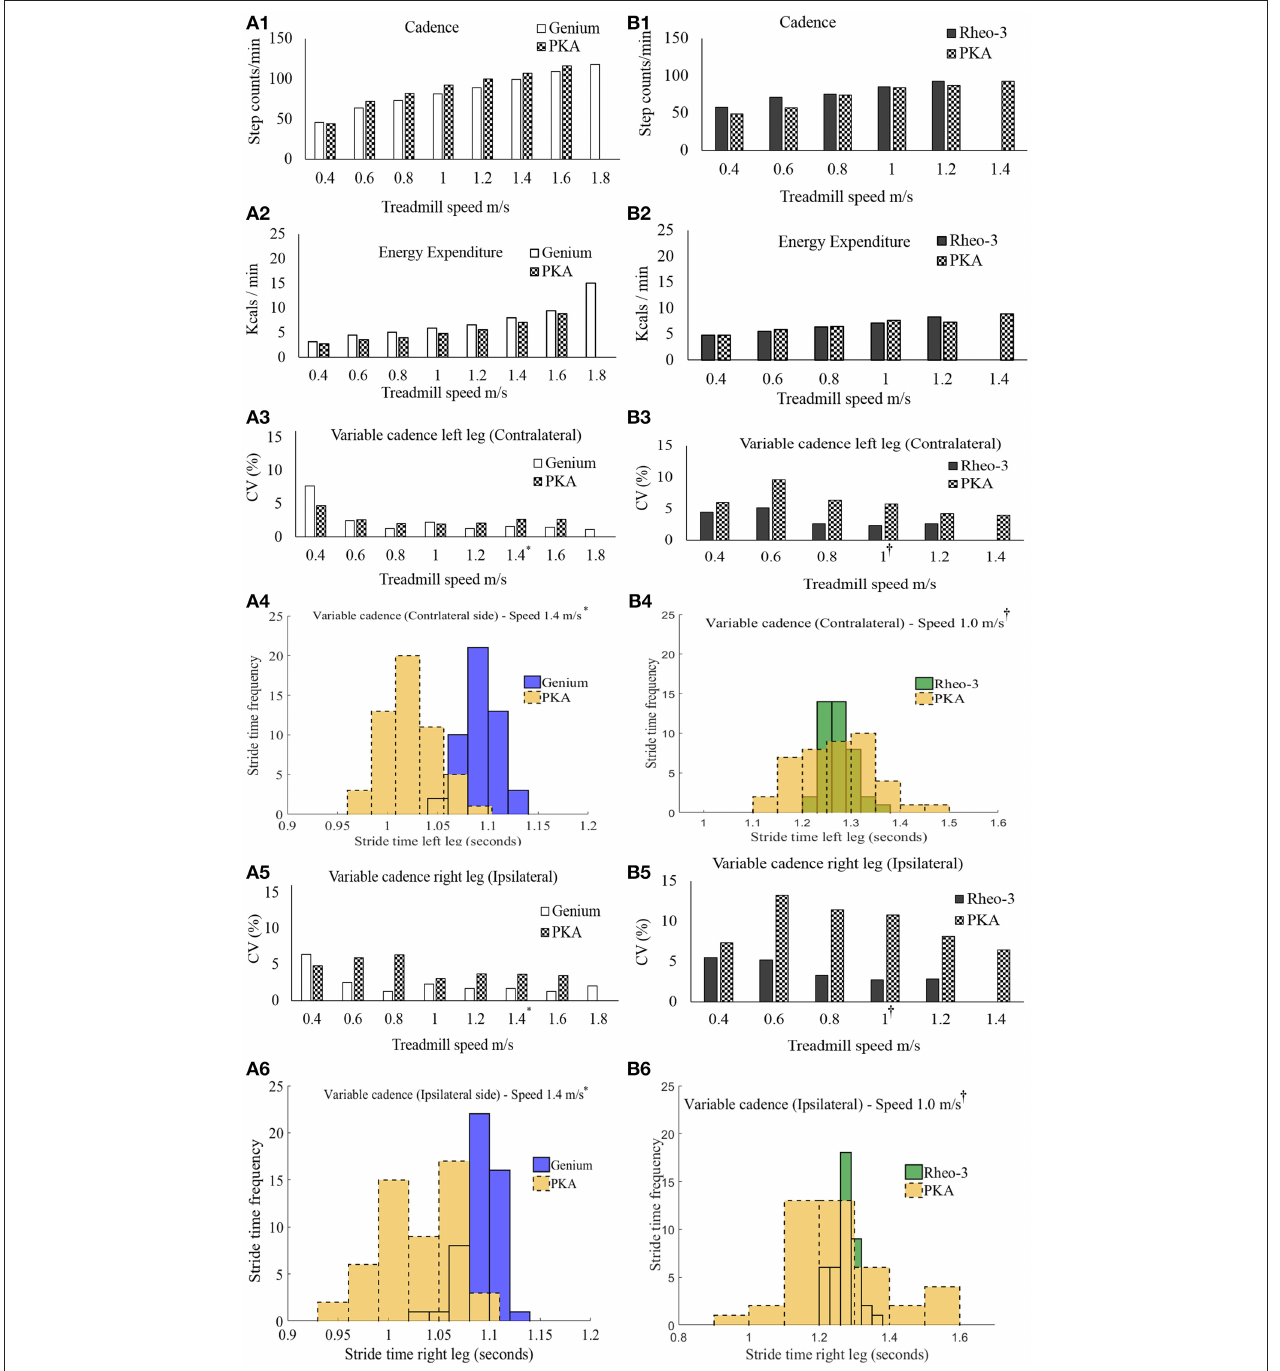
FIGURE 2 | Summary of outcome metrics from the modified graded treadmill test (GTT). Panels (A1–A6) are GTT outcome metrics for participant CS01 and panels (B1–B6) are GTT outcome metrics for participant CS02. (A1,B1) compares the cadence during the GTT between the MPK-1(Genium) vs. PKA and MPK-2(Rheo-3) vs. PKA respectively. (A2,B2) compares the EE during GTT between the MPK-1 (Genium) vs. PKA and MPK-2 (Rheo-3) vs. PKA respectively. (A3,B3) Compares the coefficient of variation (CV%) for the stride time between the MPK-1(Genium) vs. PKA (in panel A3 ) and MPK-2(Rheo-3) vs. PKA (in panel B3 ) respectively for the contralateral limb. (A4,B4) shows the stepwise stride time for the contralateral side during a representative 1min treadmill walk for MPK-1(Genium) vs. PKA [(in panel A4 ): at treadmill speed of 1.4m/s (*preferred treadmill speed of the participant CS01)] and MPK-2(Rheo-3) vs. PKA [(in panel B4 ): at treadmill speed of 1m/s ( † preferred treadmill speed of the participant CS02)]. (A5,B5) Compares the coefficient of variation (CV%) for the stride time between the MPK-1(Genium) vs. PKA (in panel A5 ) and MPK-2(Rheo-3) vs. PKA (in panel B5 ) respectively for the ipsilateral limb. (A6,B6) shows the stepwise stride time for the contralateral side during a representative 1min treadmill walk for MPK-1(Genium) vs. PKA [(in panel A6 ): at treadmill speed of 1.4m/s] and MPK-2(Rheo-3) vs. PKA [(in panel B6 ): at treadmill speed of 1m/s].